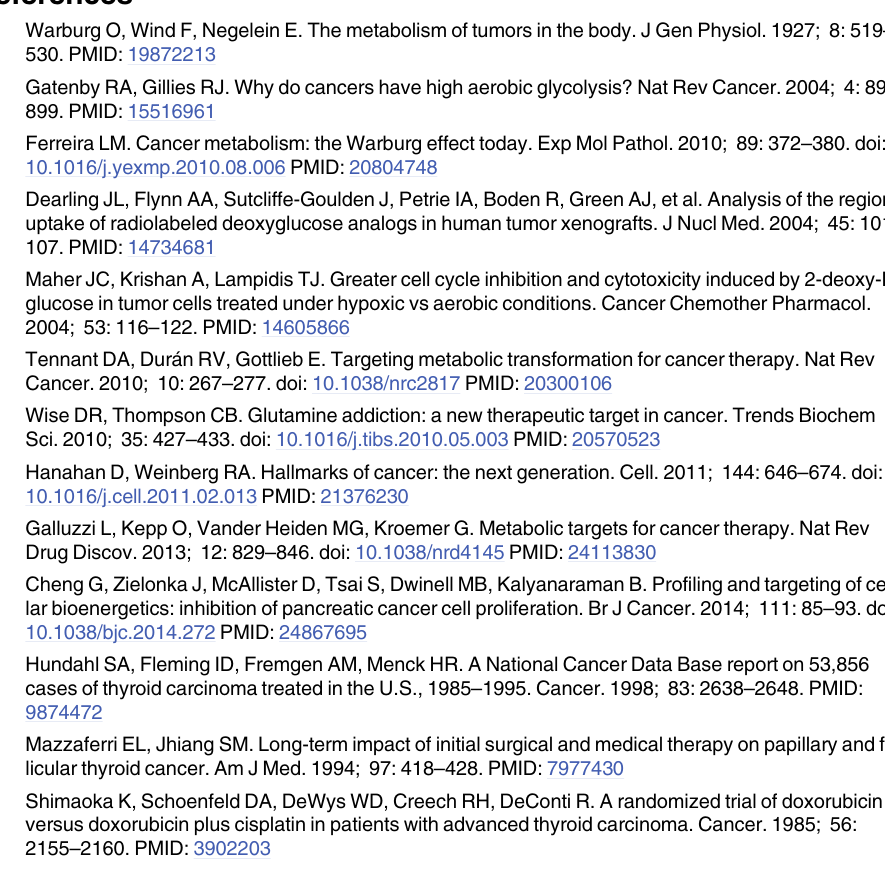
S1 Fig. Effect of 2-DG on the mRNA expression of glycolytic genes in PTC cells. Relative expression of hexokinase II (HKII), glyceraldehyde-3-phosphate dehydrogenase (GAPDH), enolase 1 (ENO1), M2 isoform of pyruvate kinase (PKM2), and lactate dehydrogenase-A (LDH-A) mRNA in BCPAP and CG3 cells treated for 48 h with 0, 0.0625, 0.25, 1, and 4 mM 2-DG. (cid:1) p < 0.05, compared to controls ( t test). The data are presented as means ± standard deviation